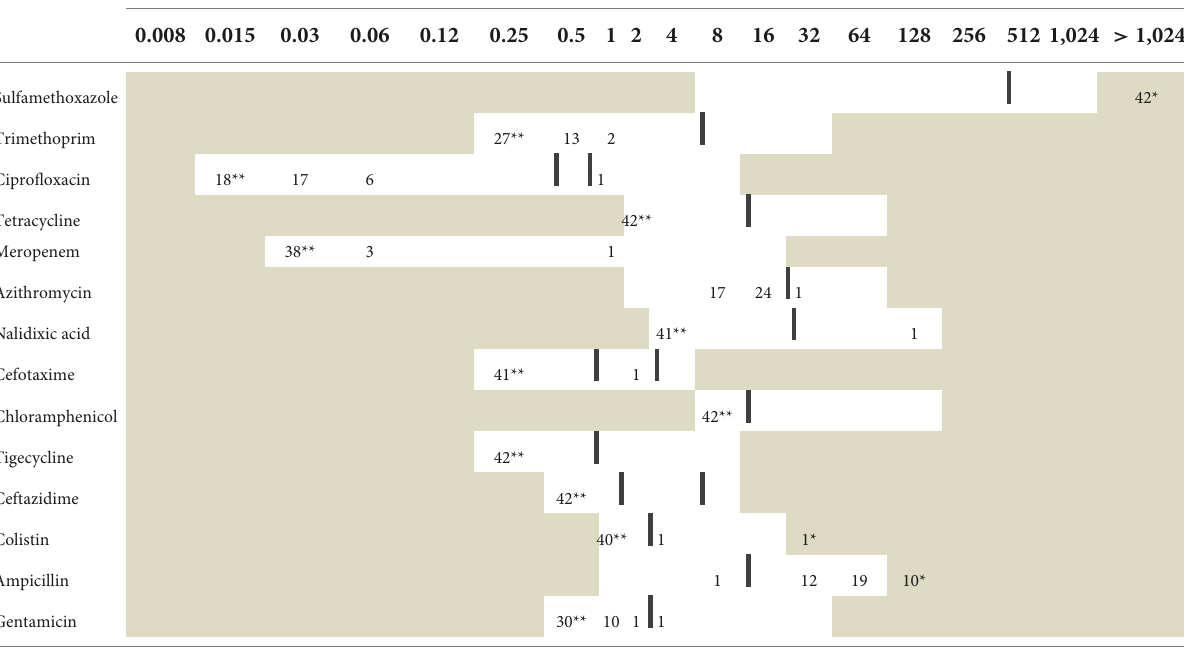
TABLE 6 Distribution of MIC values in Klebsiella spp. isolates (vertical lines—clinical breakpoints). Concentration of antimicrobial agent ( µ